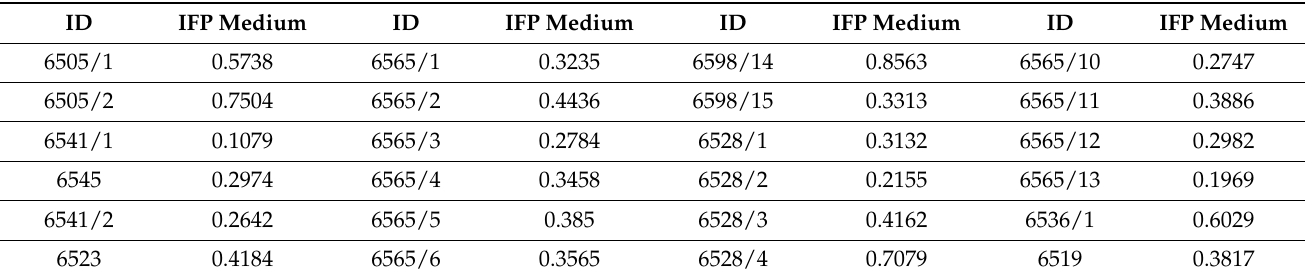
Table A1. Parcel Index